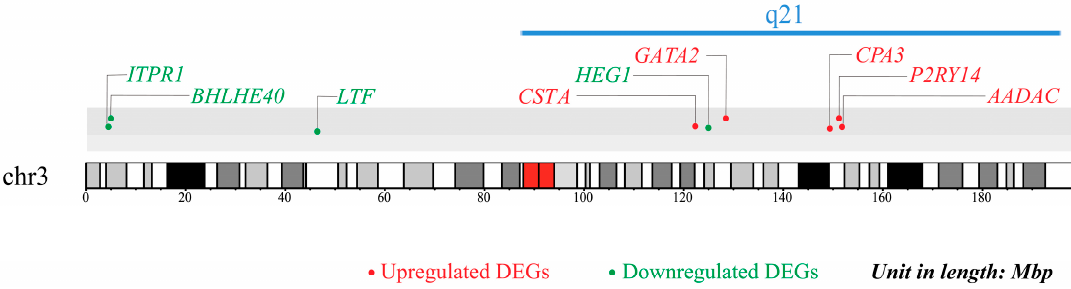
Figure 5. Chromosome localization of nine DEGs potentially associated with asthma